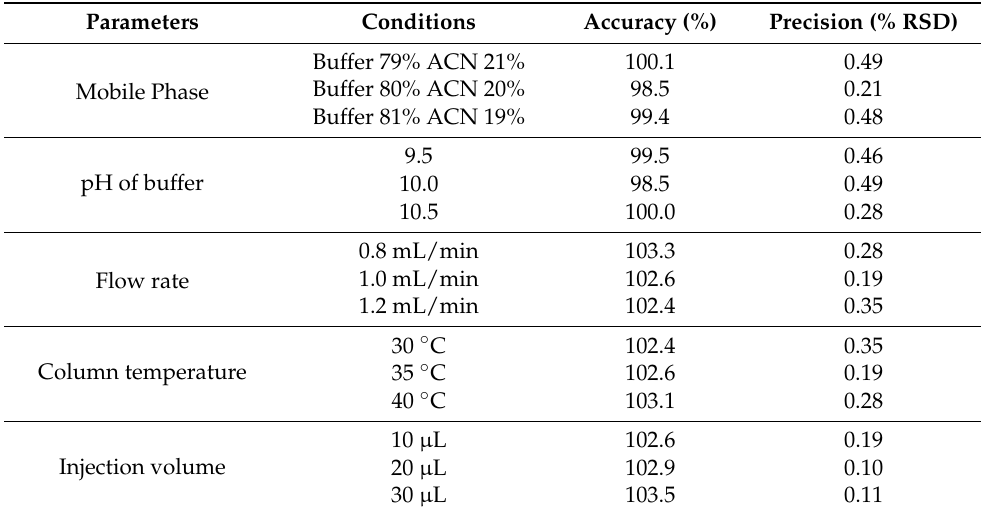
Table 3. Robustness determined by the influence of changes in chromatographic parameters on the reversed phase (RP)-HPLC method of